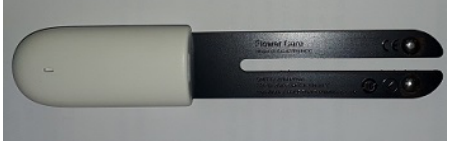
Figure 4. Xiaomi Flower Care Smart Monitor.